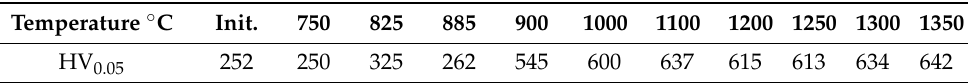
Table 2. Dependence of the ChS-139 steel microhardness on heating temperature. Temperature ◦